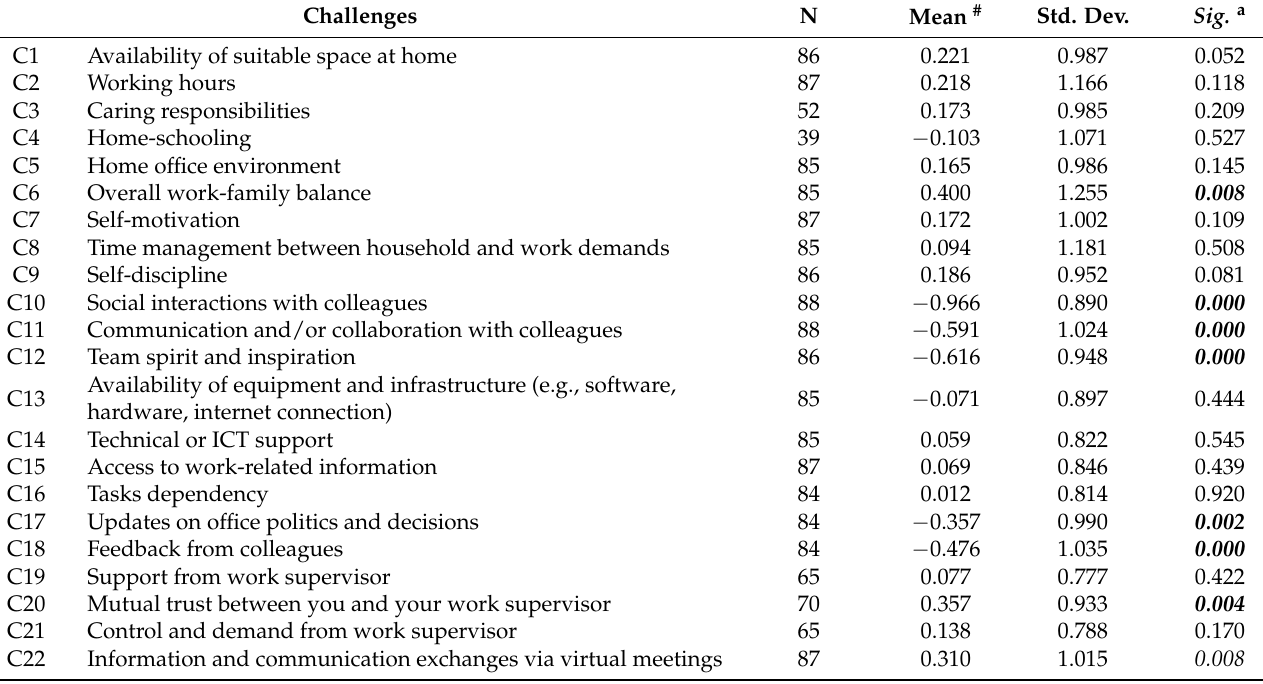
Table 3. The perceived impacts of challenges associated with WFH on work activities and perfor-